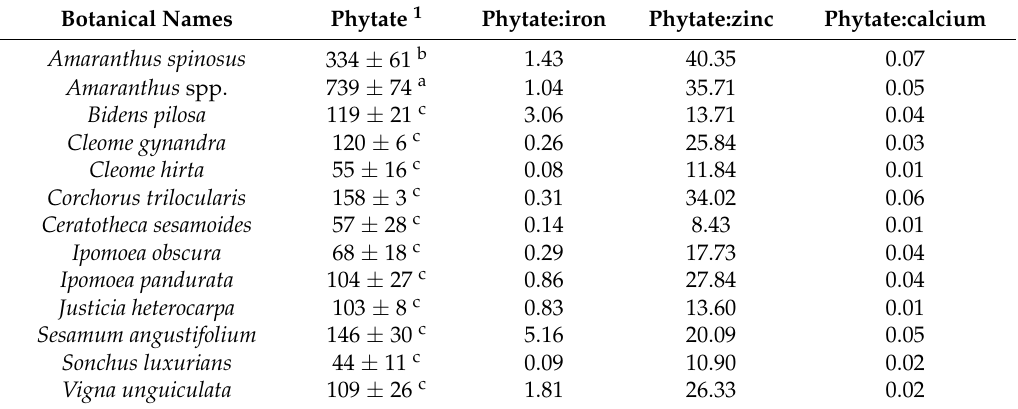
Table 6. Phytate (mg/100 g fresh weight) and its ratios to minerals in ILVs